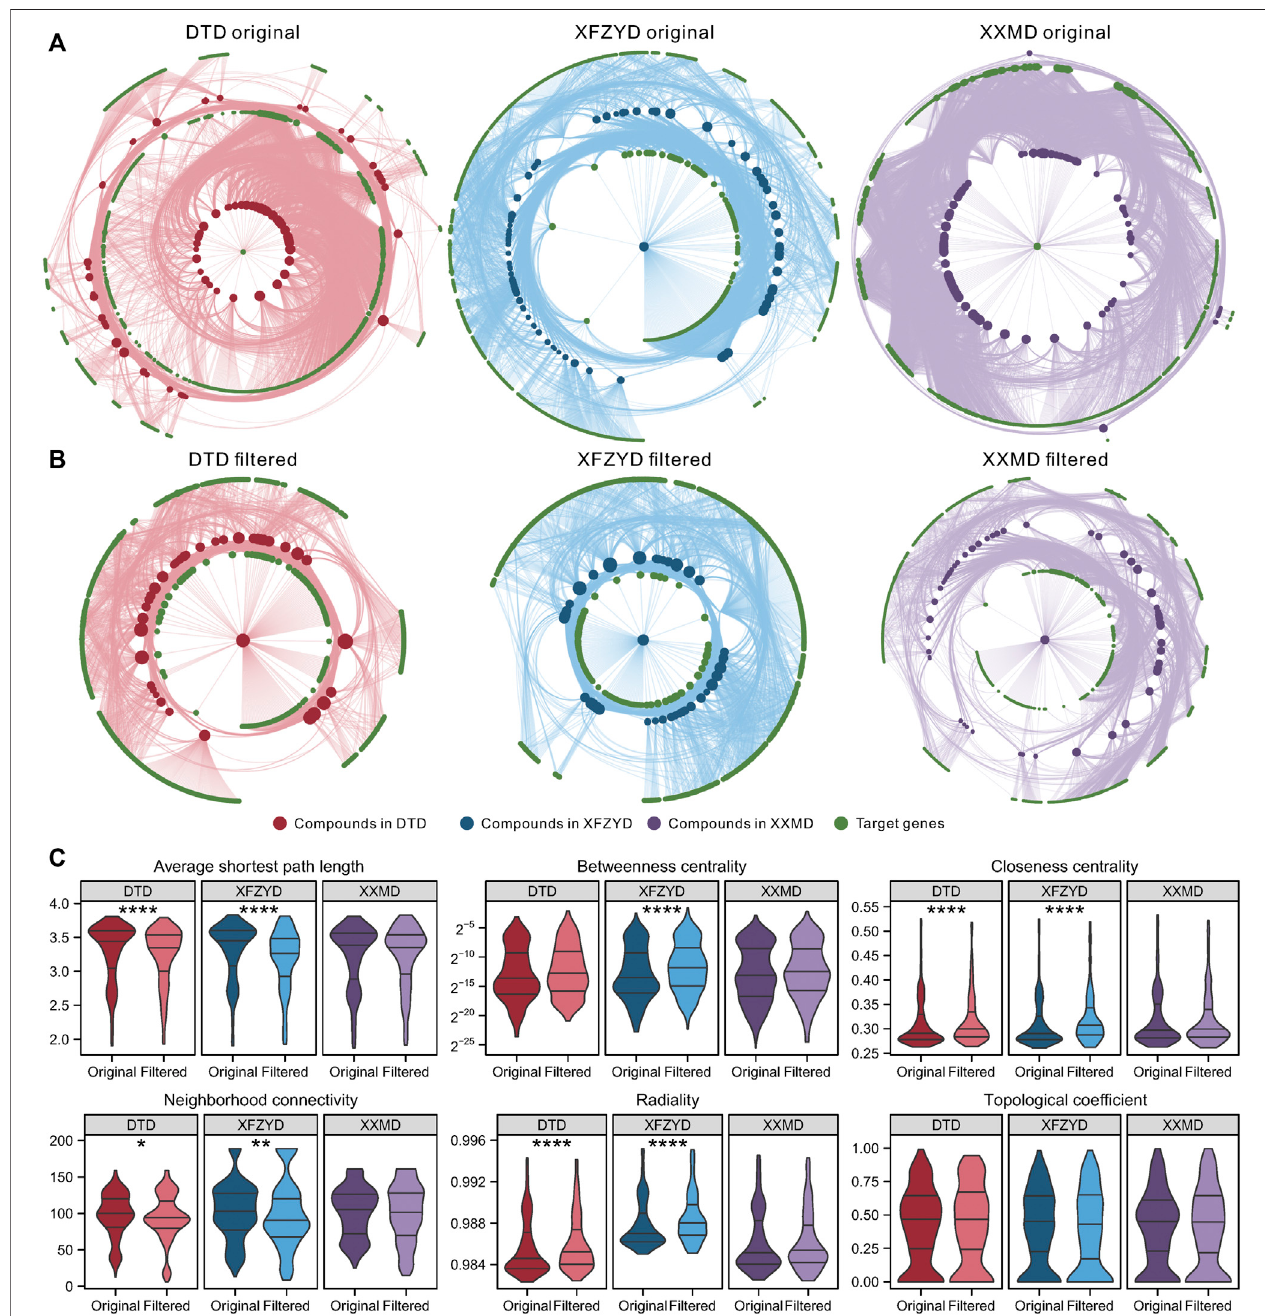
FIGURE 2 | Characteristics and topological properties of the original and fi ltered compound-target (C-T) networks: The original C-T network of DTD, XFZYD, and XXMD (A) . The fi ltered C-T network of DTD, XFZYD, and XXMD (B) . Topological properties of the original and fi ltered C-T network of DTD, XFZYD, and XXMD (C) . Signi fi cance: * p < 0.05, ** p < 0.01, *** p < 0.001, **** p < 0.0001.